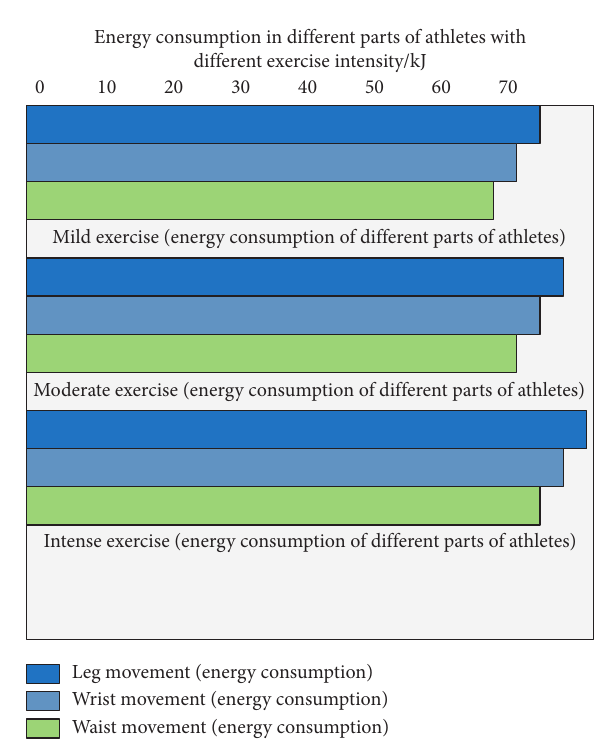
Figure 8: Estimation of exercise consumption of different parts of the human body with wearable intelligent